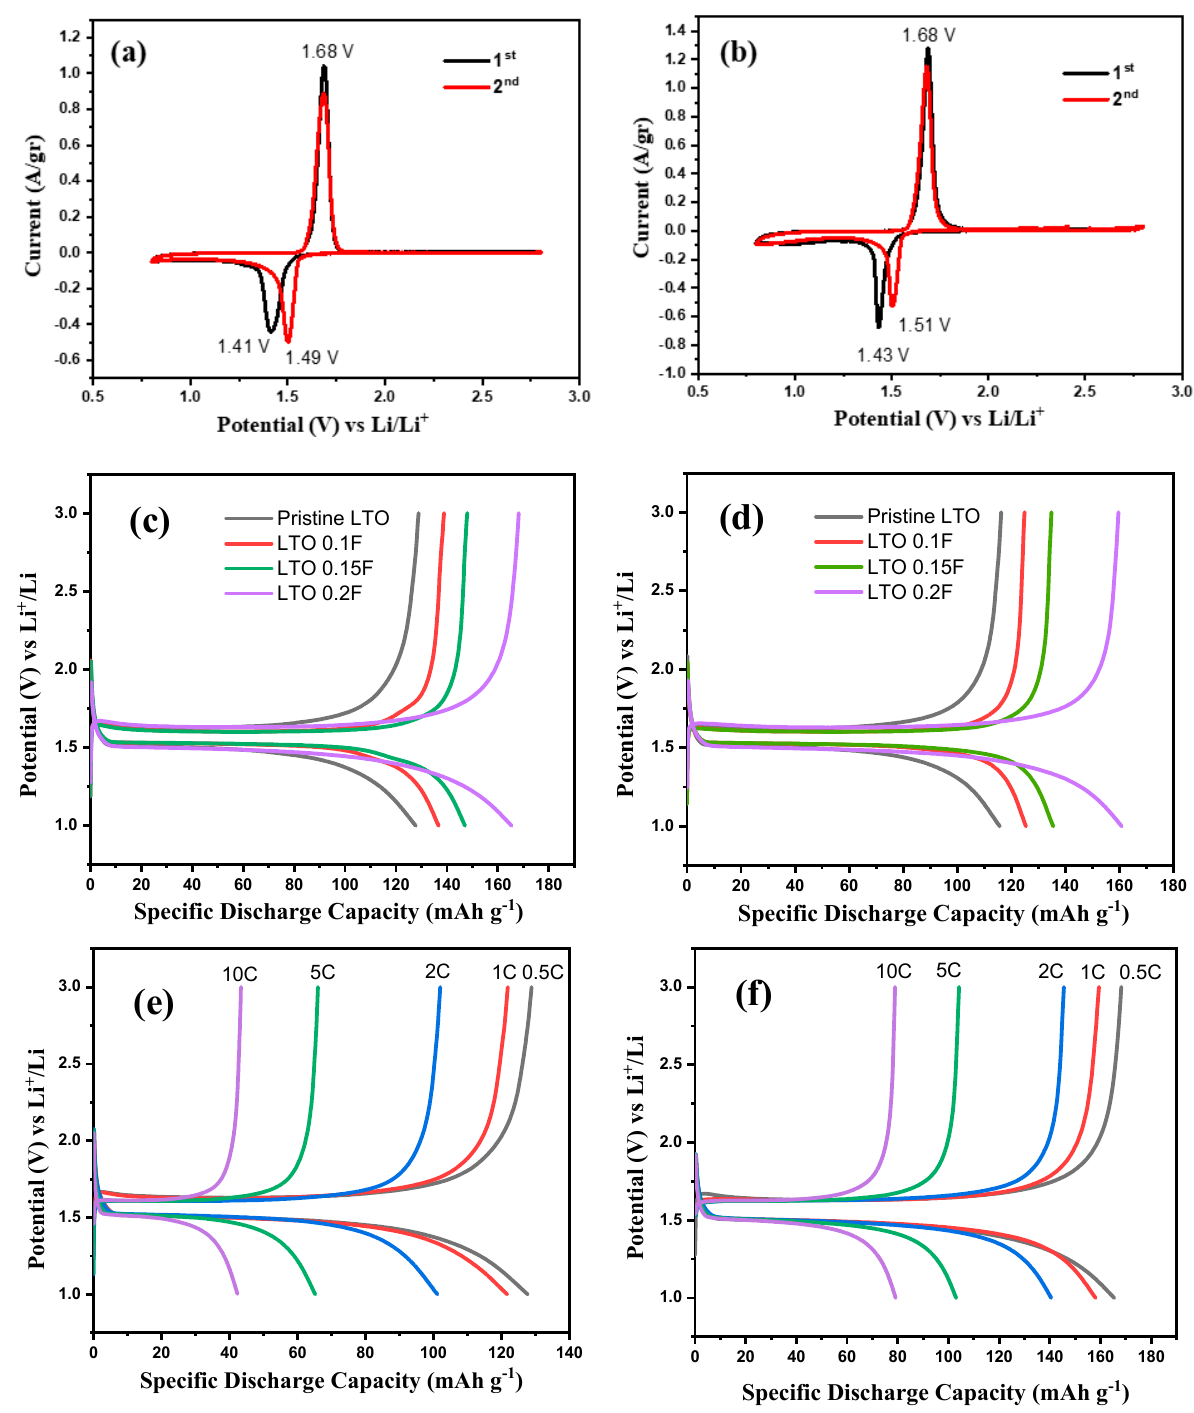
Figure 4. Cyclic voltammetry ( a ) pristine LTO, ( b ) LTO 0.2F; charge–discharge curve profile of all LTO samples at 0.5 C ( c ) initial cycle, ( d ) 10th cycle; high-rate charge–discharge curve of ( e ) pristine LTO and ( f ) LTO 0.2F.